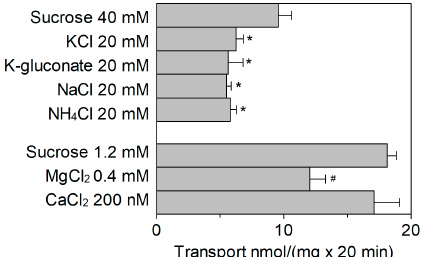
Figure 4. Effect of extraliposomal cations on the transport activity of Sl CAT2. Sl CAT2 was purified and reconstituted in proteoliposomes as described in Section 4.4. Transport was measured in 20 min, as described in Section 4.5, by adding 100 µ M [ 3 H]Arg together with the indicated compounds to proteoliposomes containing 200 mM sucrose and 15 mM ATP, at pH 7.5. Concentrations were chosen according to the average concentrations of cations in the cytosol. Results are the means ± SD from four experiments. (*), significantly different from the control (sucrose 40 mM) for p < 0.05 as calculated from 1Way ANOVA test. (#), significantly different from the control (sucrose 1.2 mM) for p < 0.05 as calculated from 1-way ANOVA